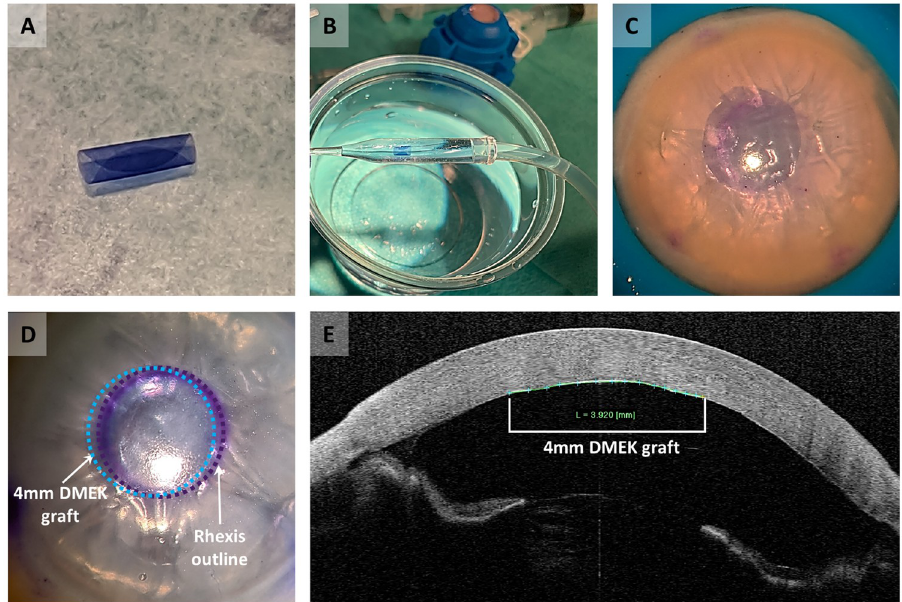
Fig 2. In vitro surgery performed with the small diameter DMEK graft. (A) Graft staining with 0.06% trypan blue. (B) Graft loading into a straight DMEK injector. (C) Descemetorhexis performed on a cornea mounted on an artificial anterior chamber. (D) Graft unfolding and positioning in the descemetorhexis area performed in a whole globe. Purple dashed line indicates the outline of the descemetorhexis, and the blue dashed line indicates the position of the